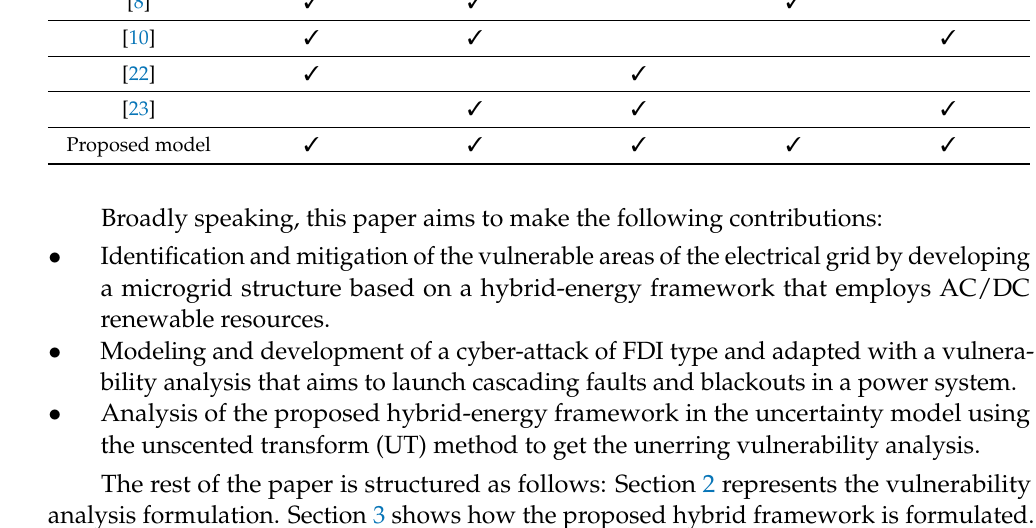
Table 1. Categorization of the different approaches. AC Microgrid DC